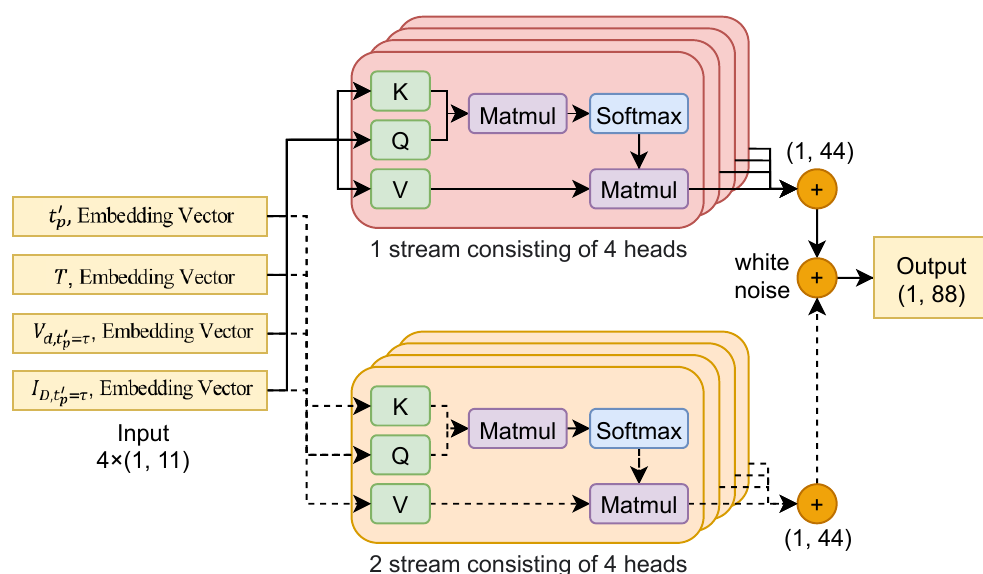
Figure 5. Overview of multihead self-attention model.